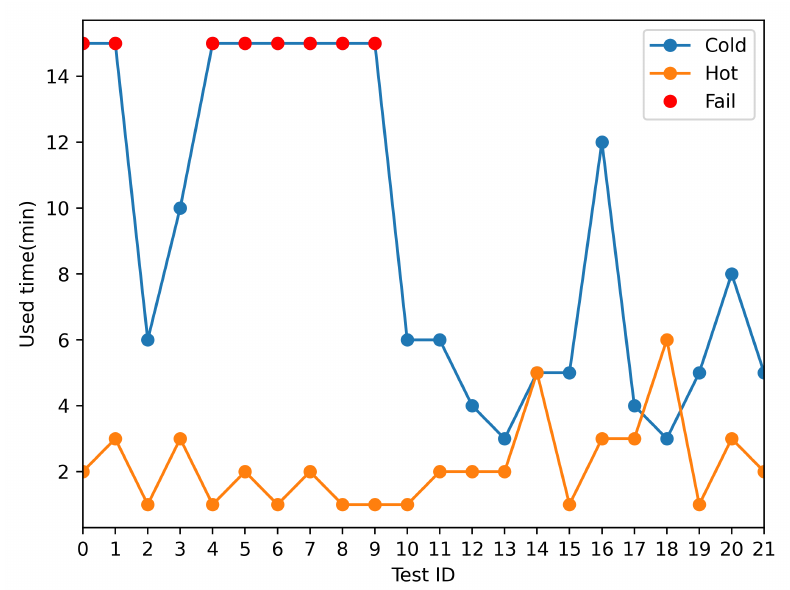
Figure 28. GNSS cold and hot start test result.